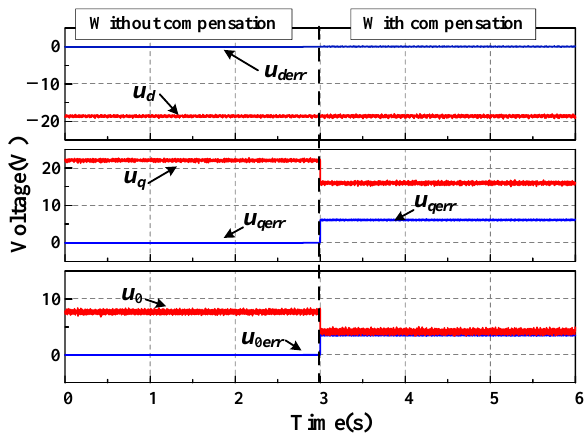
Figure 10. Nonlinearity compensation.